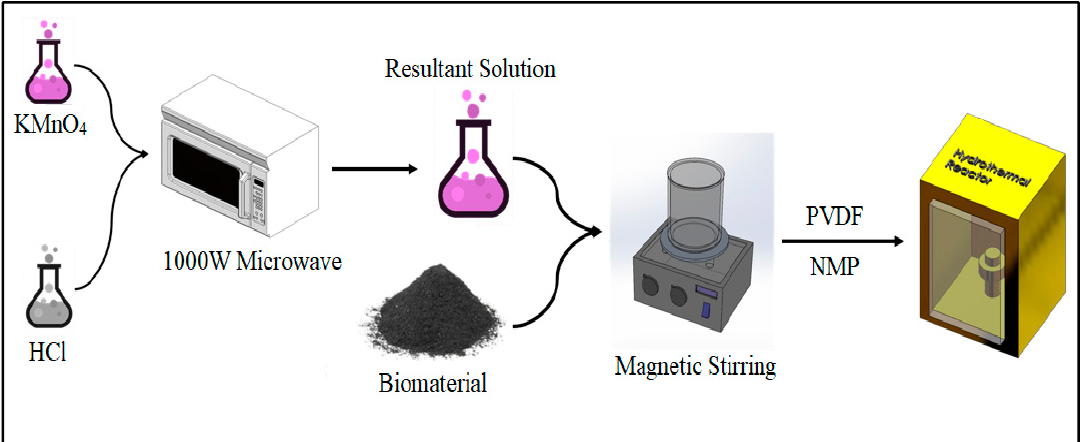
Figure 1. Schematic for the preparation of the electroactive materials.